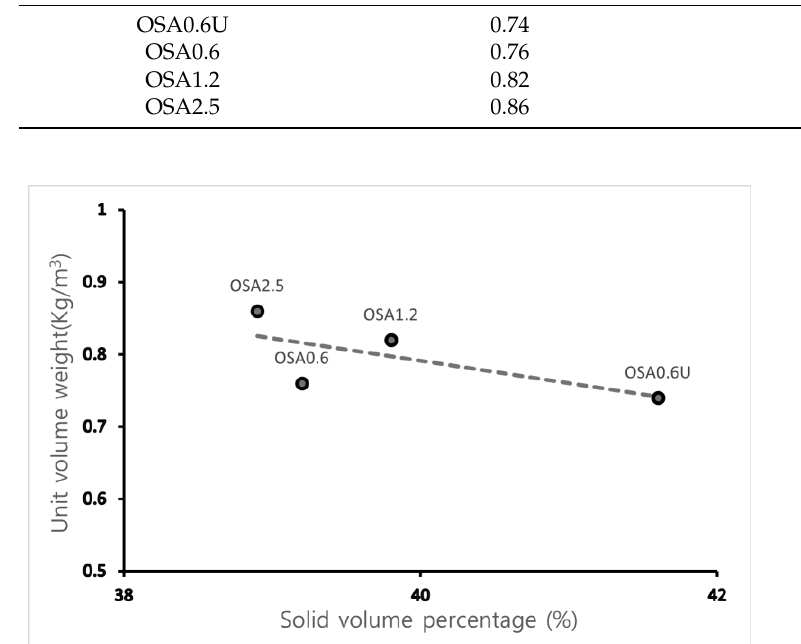
Figure 6. Solid volume percentage – unit volume weight of the oyster shells.